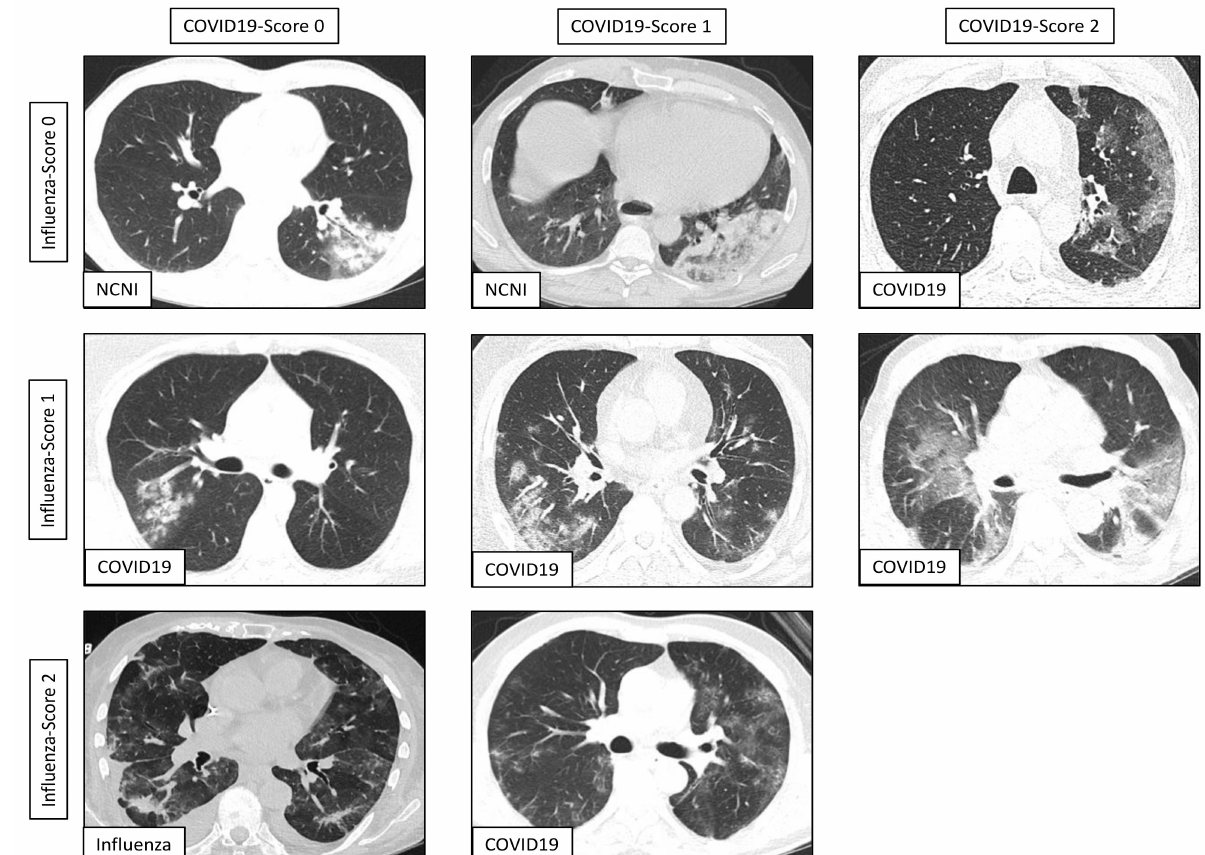
Figure 2. Representative findings from CT scans depicting pneumonia including radiologists’ scoring for COVID-19 and influenza suspicion (3 × 3 matrix) as well as corresponding subgroup belongings (in-image bottom left ) according to RT-PCR results. Images include typical as well as atypical features related to the subgroups, e.g., patchy consolidations without relevant ground glass opacities (GGOs) as an atypical example for COVID-19 ( middle left ). There was no CT radiologically classified with co-occurrent high suspicions (reading scores 2) for COVID-19 as well as